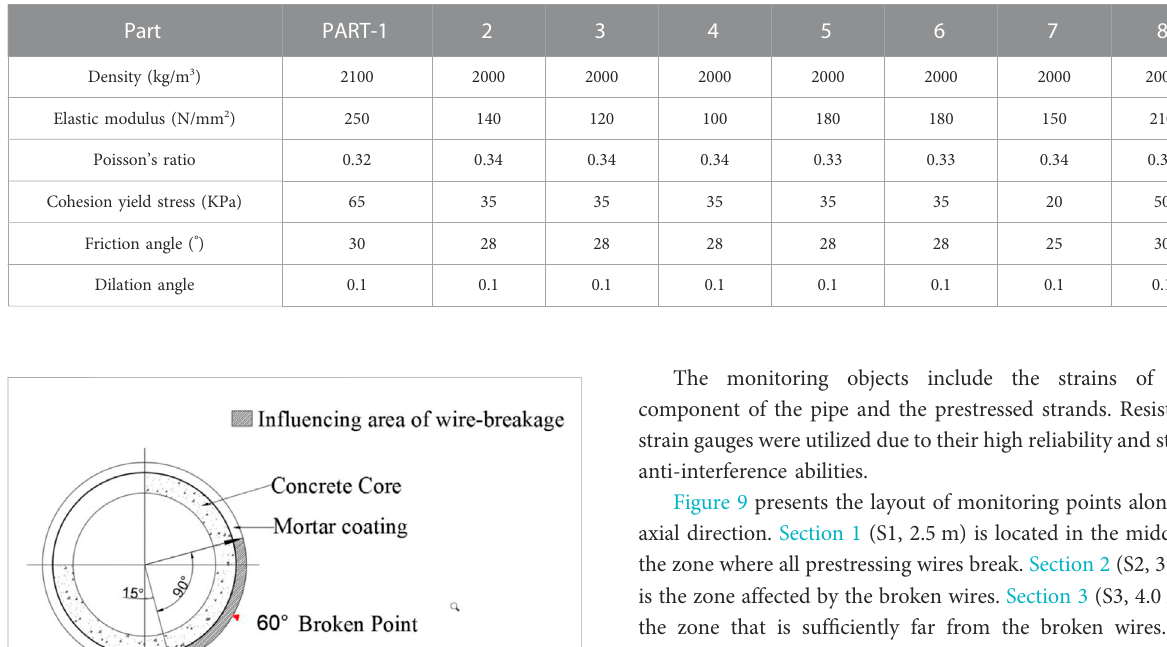
TABLE 3 Material properties of the surrounding soil.